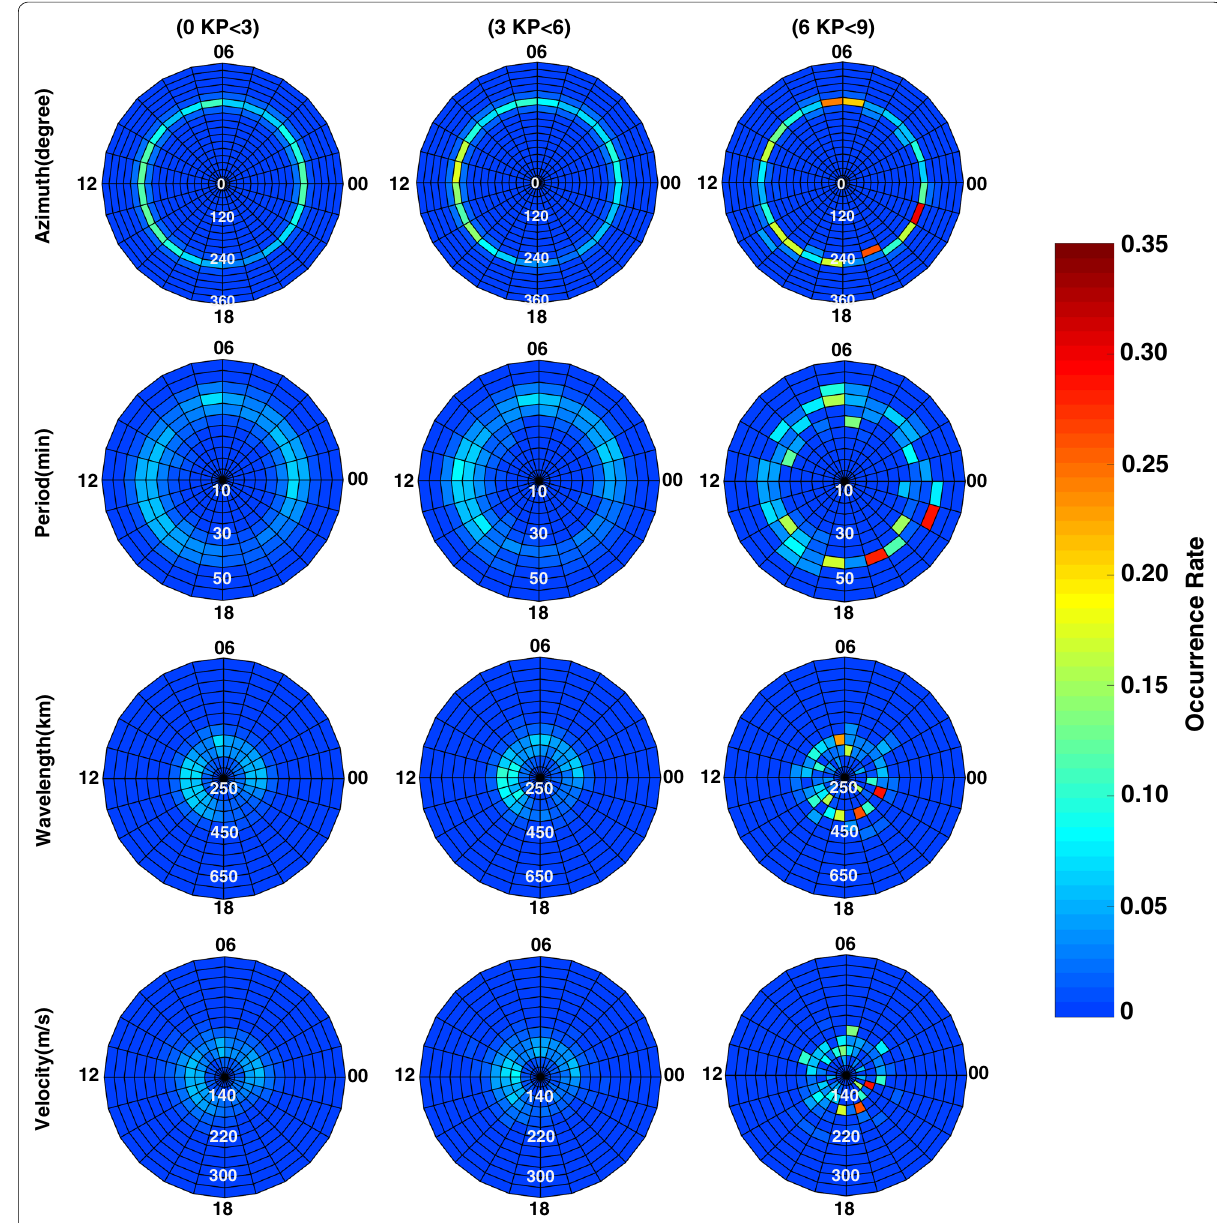
Fig. 7 LT variations in the propagation parameters of MSTIDs under different geomagnetic activity